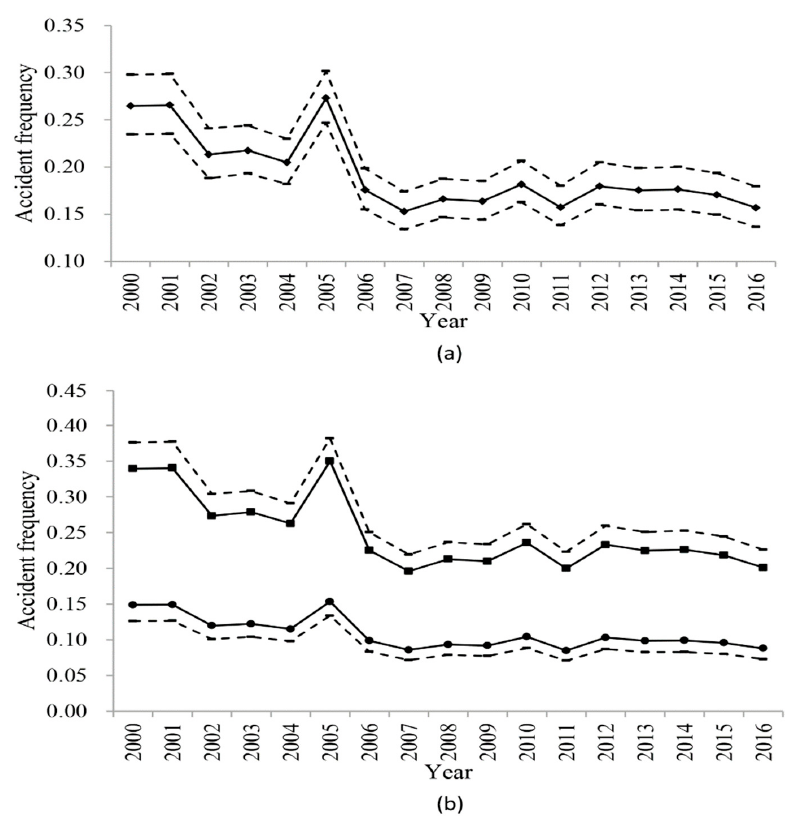
Figure 6. ( a ) Uncertain time series when the rate of underreporting is 50%; ( b ) Uncertain time series when the rate of underreporting ranges from 11% to 61%.